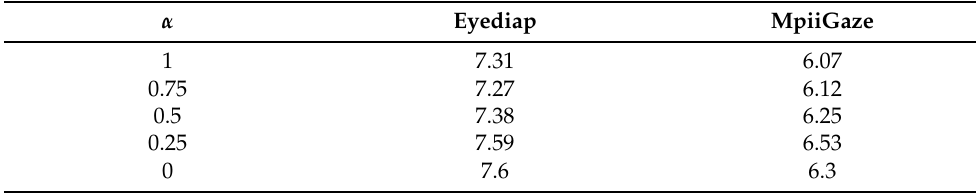
Table 4. The performance of Mnist [5] with different α